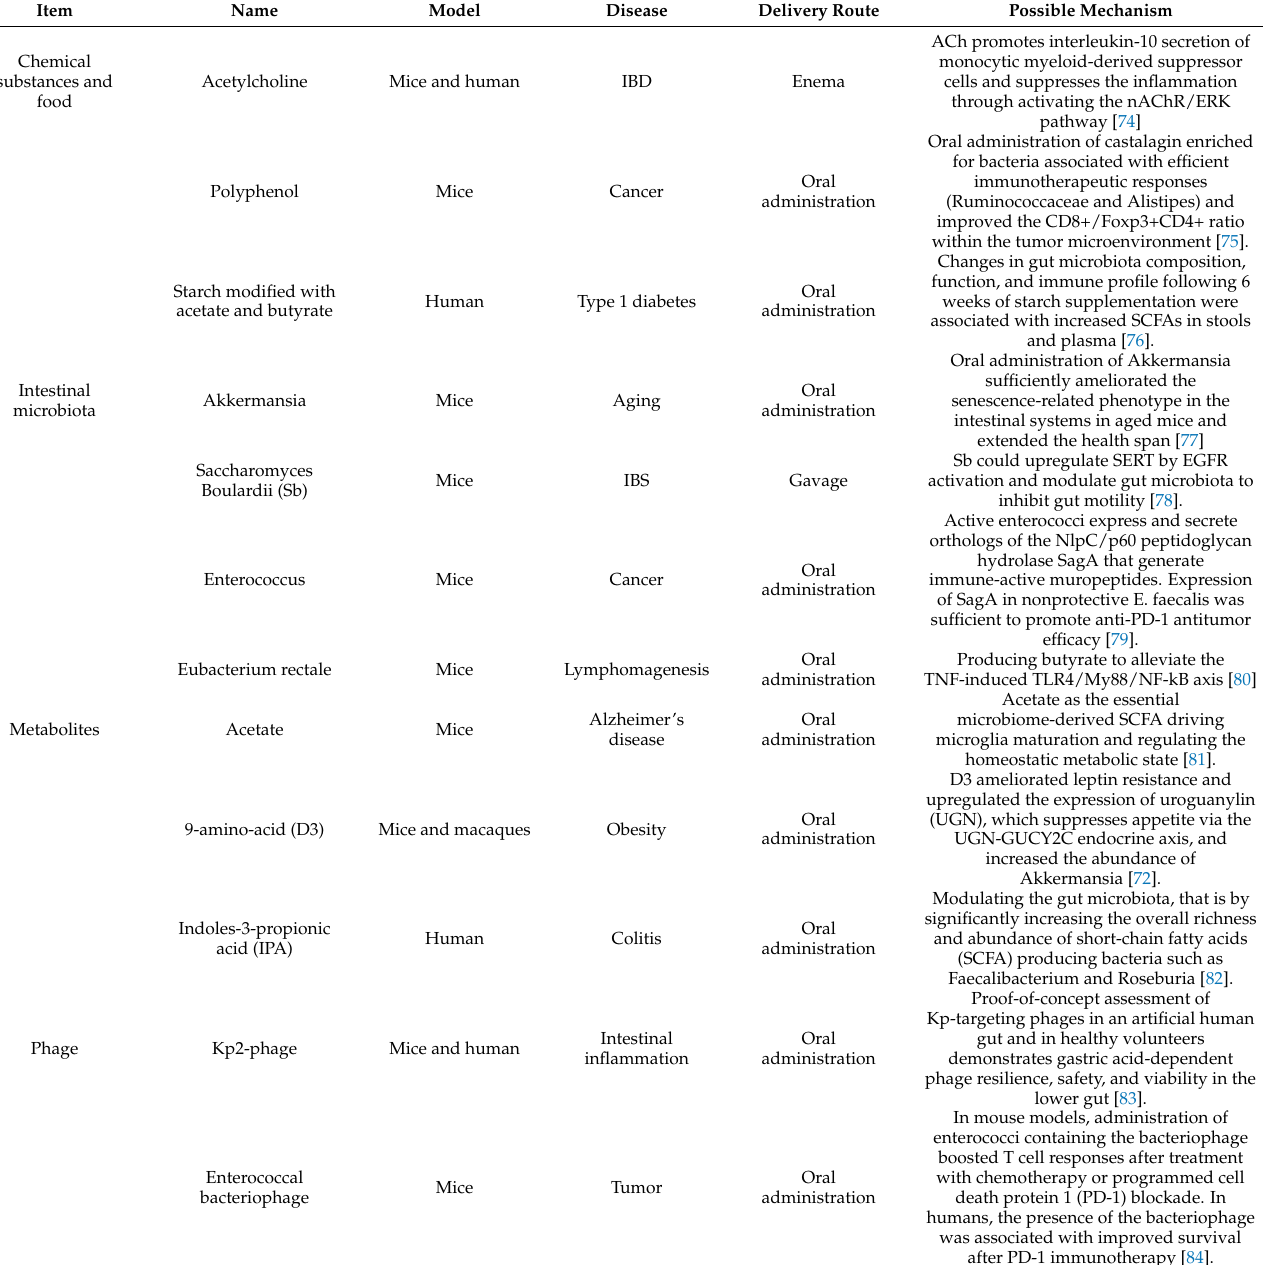
Table 3. The potential substances for the prevention or treatment of